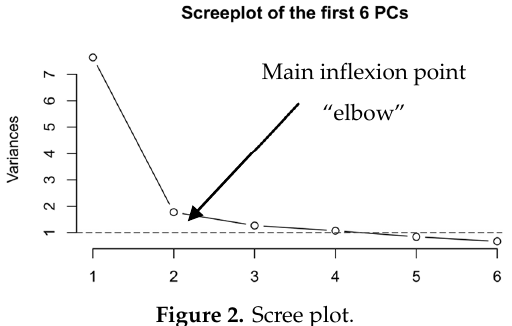
Figure 2. Scree plot.